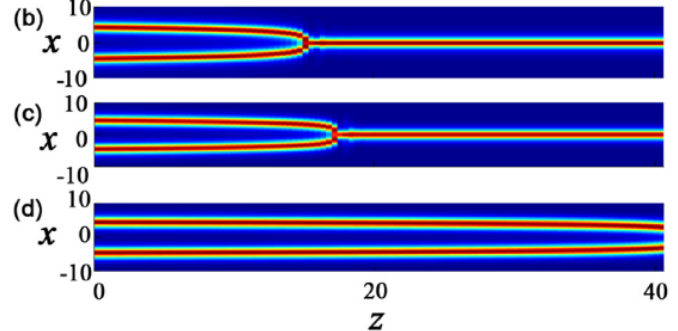
Figure 10. The merger of initially separated stable dissipative solitons with zero phase difference between them, as produced by simulations of the fractional cubic-quintic CGLE (35), with parameters δ = 0.3, β = 0.1, ε = 1.7, ν = 0.115, and µ = 1, and different values of the Lévy index: α = 1.5 ( b ), 1.8 ( c ), and 2.0 ( d ). Adapted with permission from Reference [39]. Copyright 2020 Elsevier. Panel (a) from the original figure is not included here, as it is not necessary" at the end of the